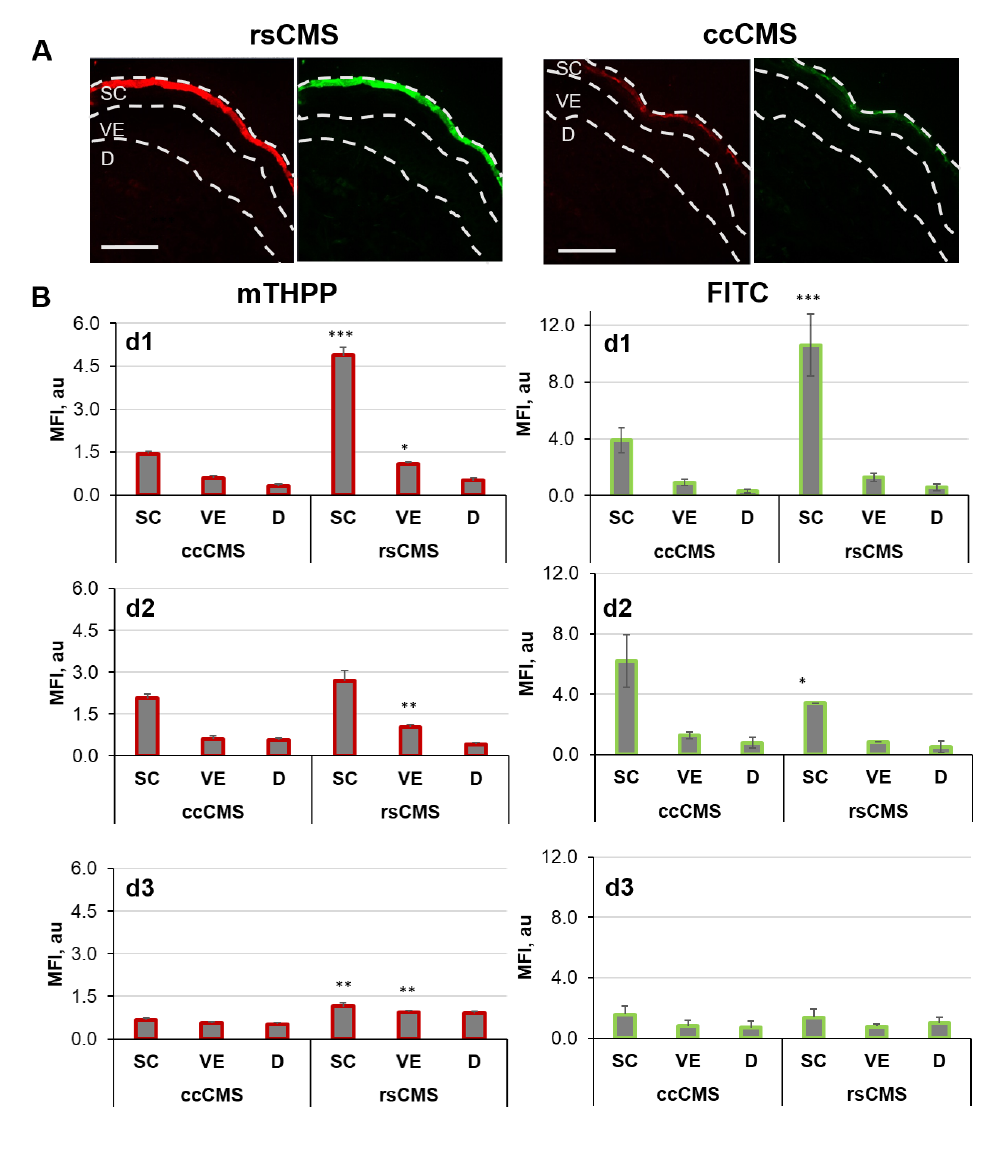
Figure 3. Penetration of ccCMS 1b and rsCMS 1a nanocarriers in ex vivo human skin and delivery of the loaded dye meso-tetra ( m -hydroxyphenyl) porphyrin (mTHPP). ( A ) Representative images of skin sections from rsCMS 1a and ccCMS 1b nanocarrier-treated samples. Bars = 50 µm. ( B ) Summary of the mean fluorescence intensity (MFI) and standard errors from three different donors (d1-d3). Statistical analysis was performed to compare rsCMS 1a values with those of ccCMS 1b nanocarriers in the same skin layers. The stars show significant differences (* p < 0.05; ** p < 0.01; *** p < 0.001).